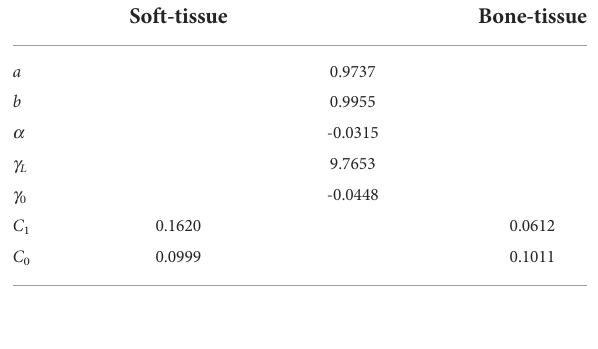
TABLE 2 Fit parameters obtained using VMIs of Gammex (calibration) phantom at 60 and 180